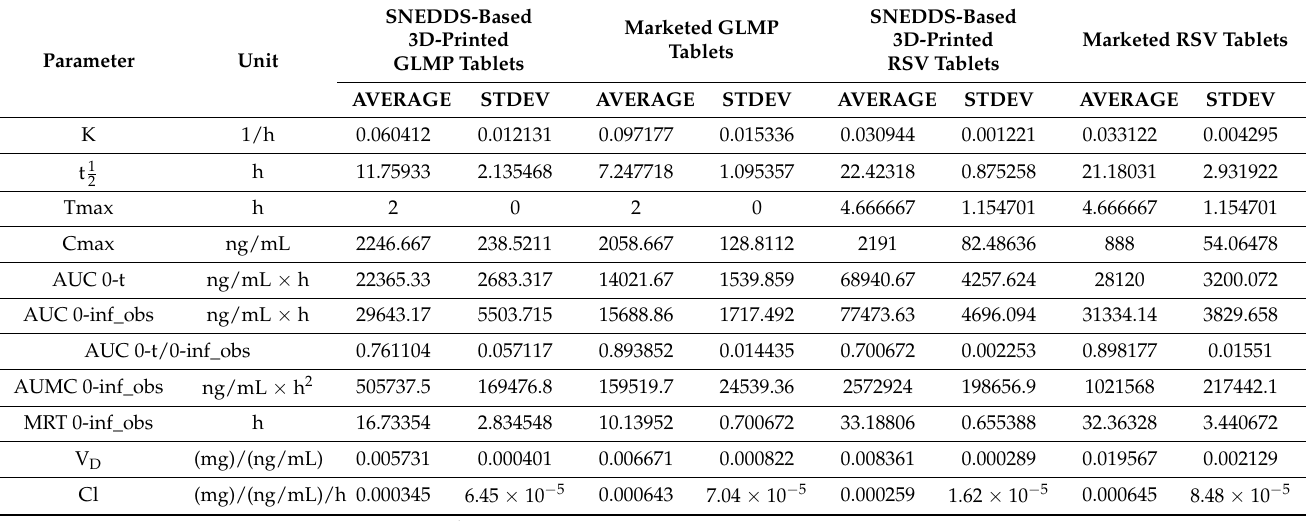
Table 3. Pharmacokinetic parameters of glimepiride and rosuvastatin after oral administration to Male Wistar rats (n = 6).